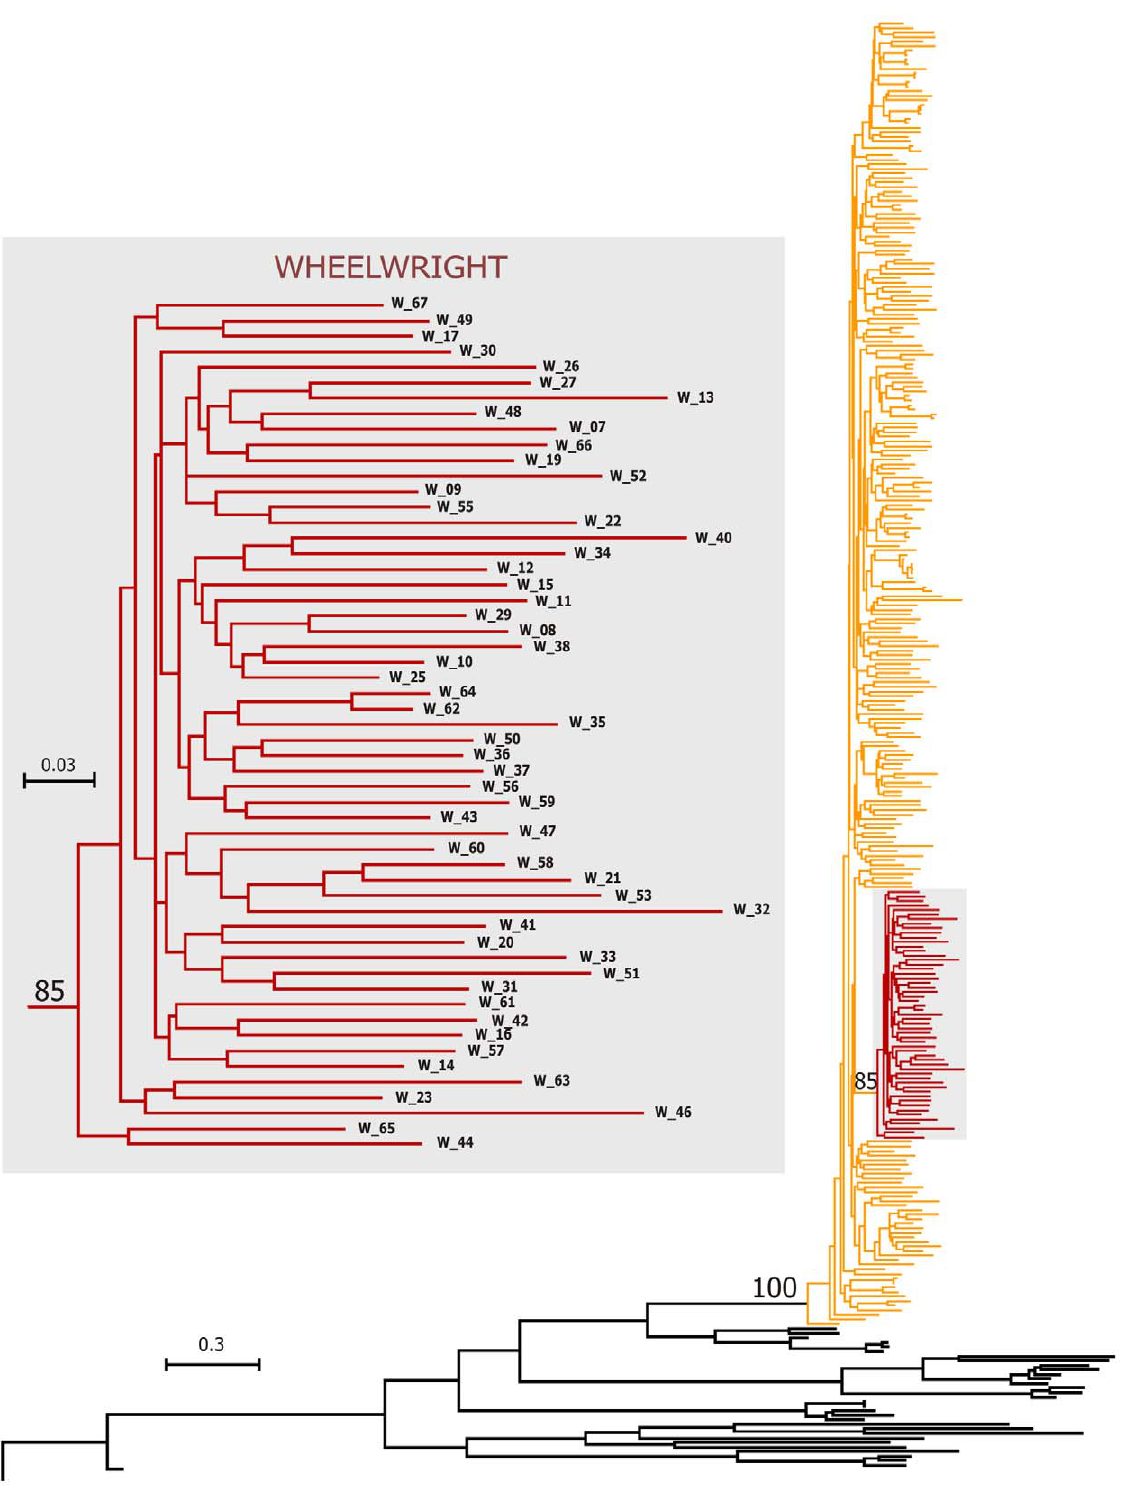
Figure 1. Maximum likelihood phylogeny of the concatenated analysis obtained with the PhyML software. A separation between sequences from the outbreak (red branches, n=55) and those from other sequences can be observed in the shaded area to the right of the figure. Genotypes 1b (references sequences, n=232) are represented by orange branches and the genotypes No-1b are represented by black branches (n=34). A close up of the Wheelwright sequences are detailed on the left of the figure, with PhyML bootstrap support for the clade at 85%. Branch lengths reflect the likelihood distances.